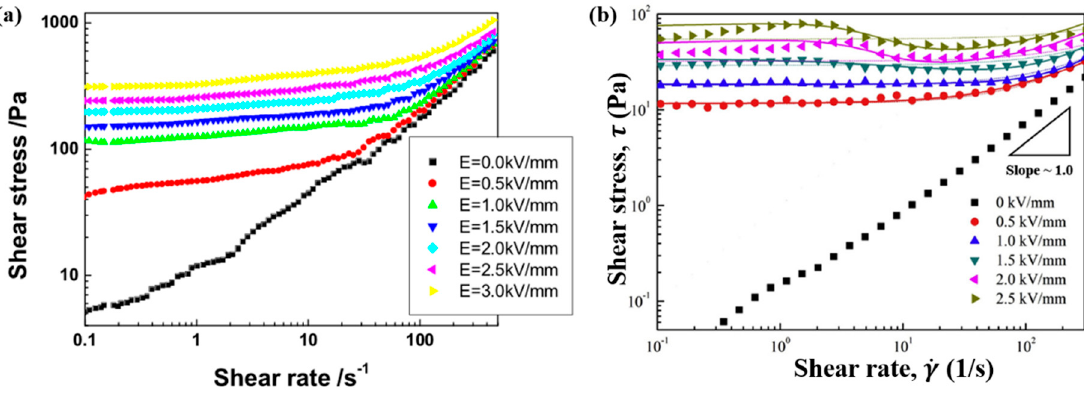
Figure 10. Shear stress curves of ( a ) flower-like Fe 2 O 3 / PANI based ER fluid (20 wt %) (Tian et al. [73], © Elsevier, 2016) and ( b ) PS / PDPA based ER fluid (5 vol % (Kim et al. [98], © Elsevier, 2017).